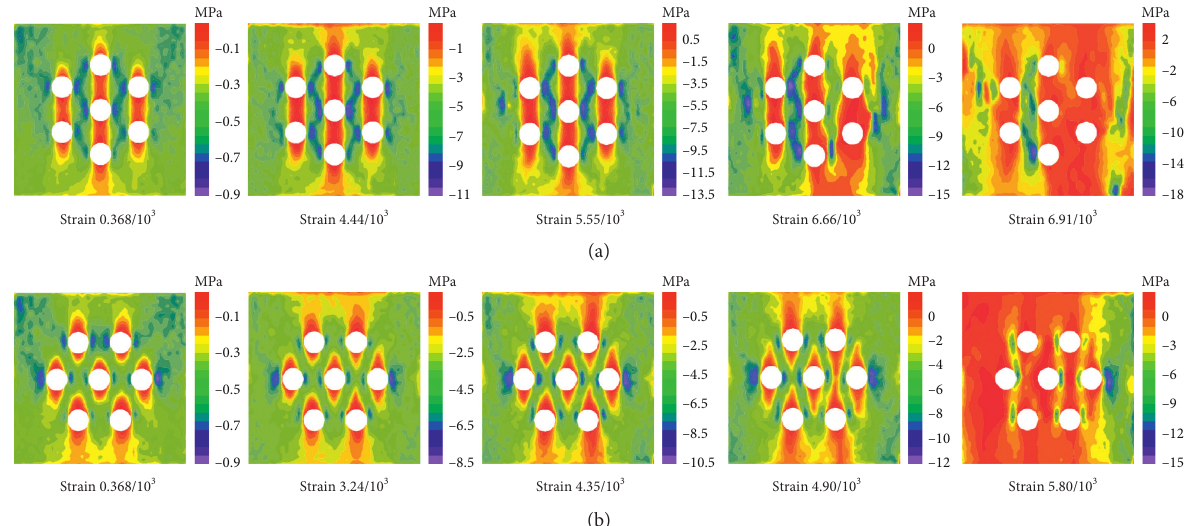
Figure 11: Evolution of stress fields in vertical and horizontal orientations of circular holes. (a) Evolution of vertical orientation stress field. (b) Evolution of horizontal orientation stress field.